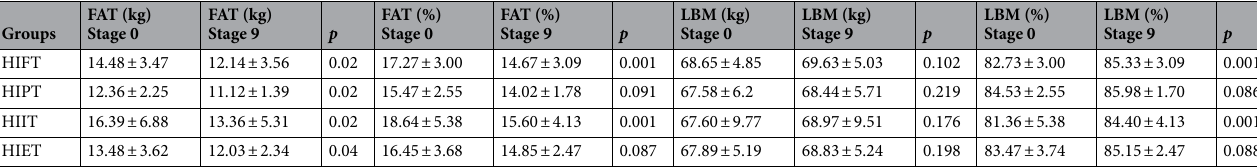
Table 2. Changes of FAT (kg and %) and LBM (kg and %) mass at stage 0 and 9 in all groups. Data are presented as mean ±